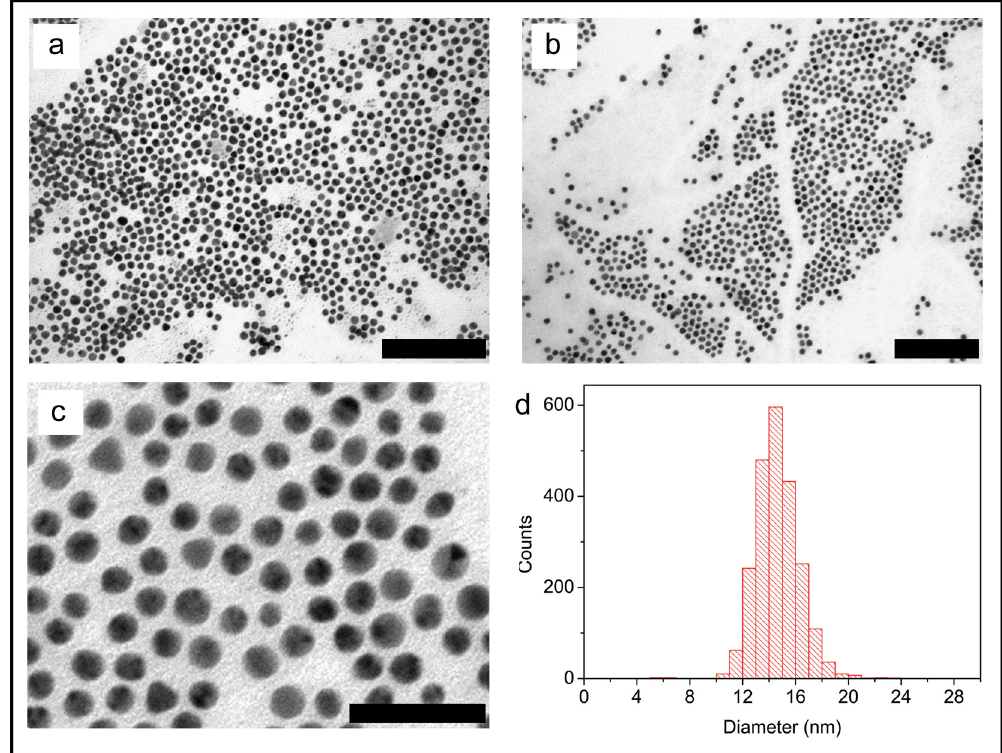
Figure 1 . Representative TEM images of MUA-capped AuNPs and size distribution. 14.6 ± 1.5 nm AuNPs were synthesized following a seeding growth mechanism. They were functionalized with MUA before imaging. Scale bars are 200 nm (A, B) and 40 nm (C). Size distribution is showed in the histogram